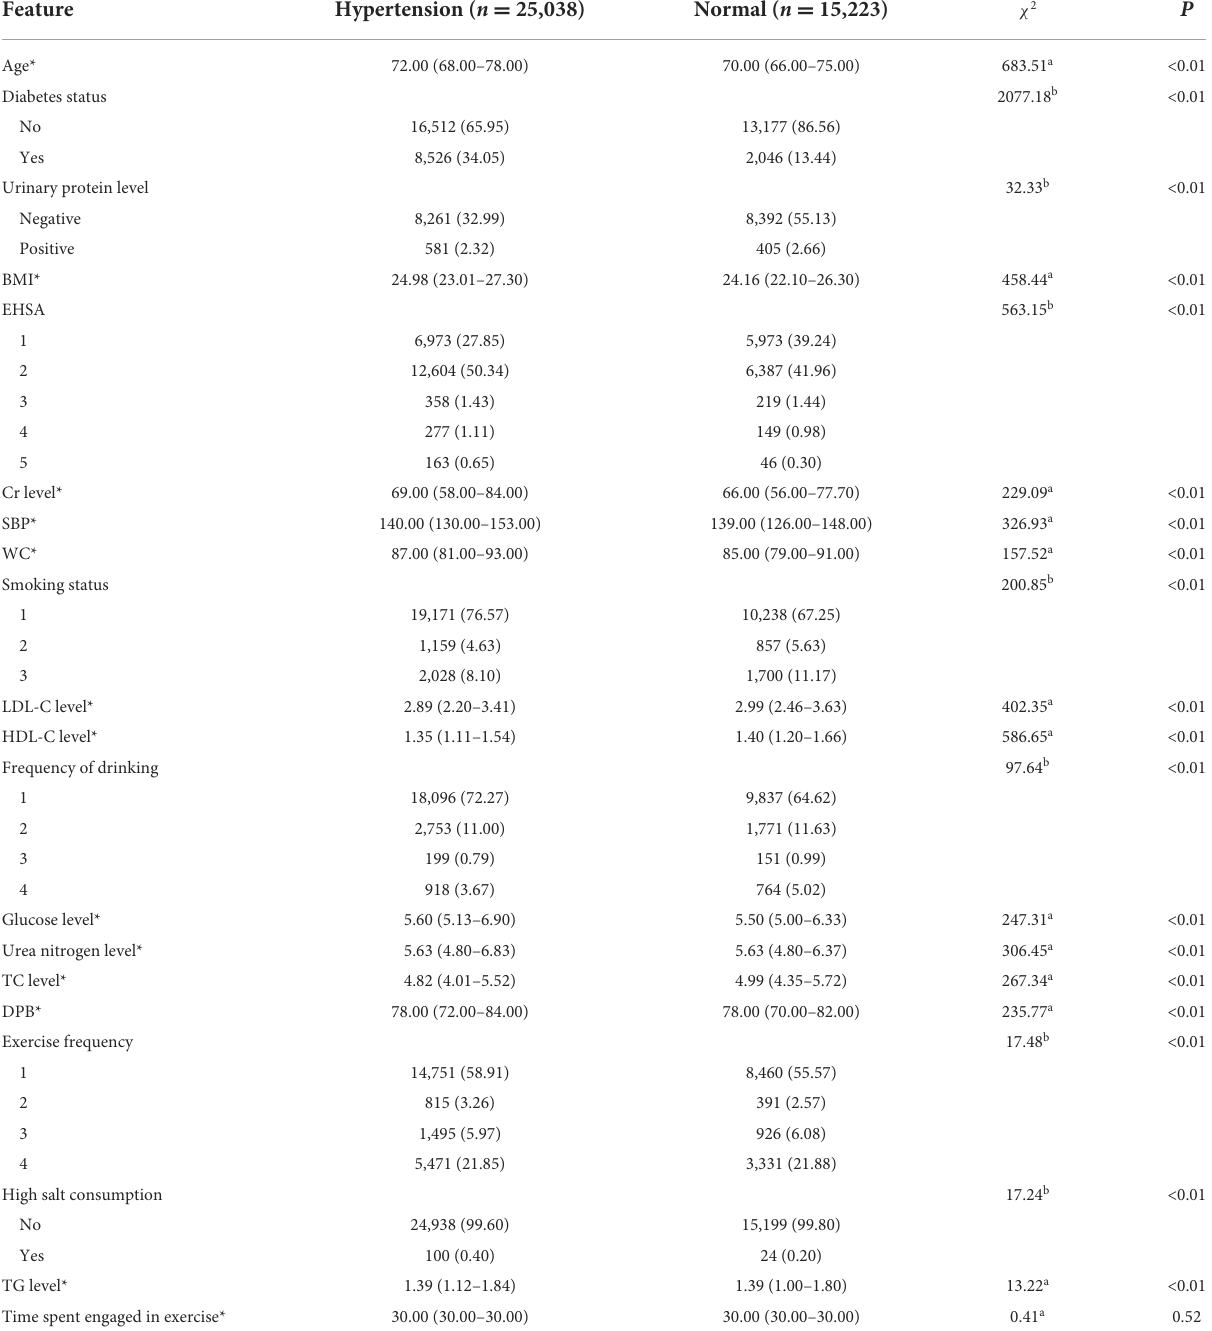
TABLE 1 Characteristics of the participants in primary care